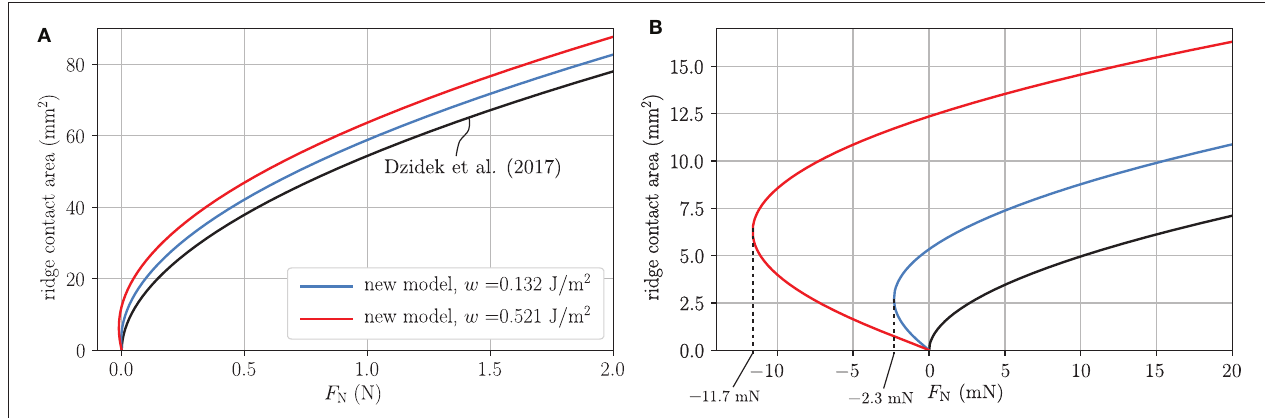
FIGURE 4 | Ridge contact area as a function of normal load for different works of electroadhesion; black curves represent the non-adhesive solution; (A) Plot over the whole loading range; (B) Enlarged view of the pull-off region associated with negative loads.